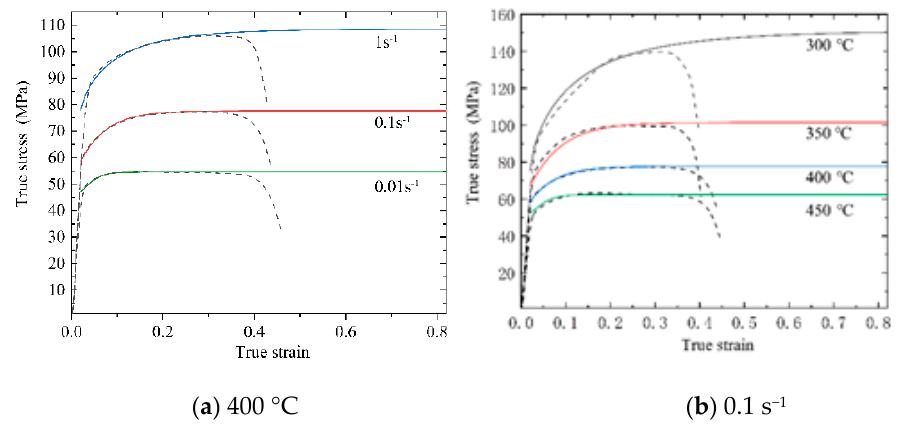
Figure 2. True stress-strain curves of different strain rates ( a ) and temperatures ( b ).